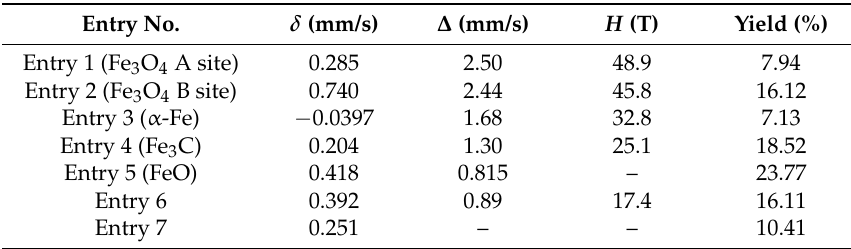
Figure 8. ( a ) XRD patterns of the B. braunii residue carbonized at 900 ◦ C. ( b , c ) 57 Fe Mössbauer spectra of the B. braunii residue carbonized at 900 ◦ C, recorded at room temperature. Table 2. 57 Fe Mössbauer parameters for B. braunii residue carbonized at 900 ◦